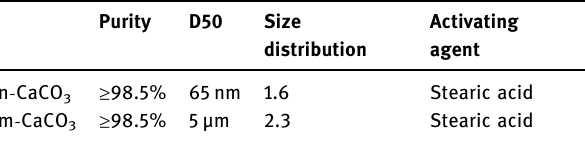
Table 1: Particle size and its distribution of CaCO 3 fi ller Purity D50 Size Activating distribution